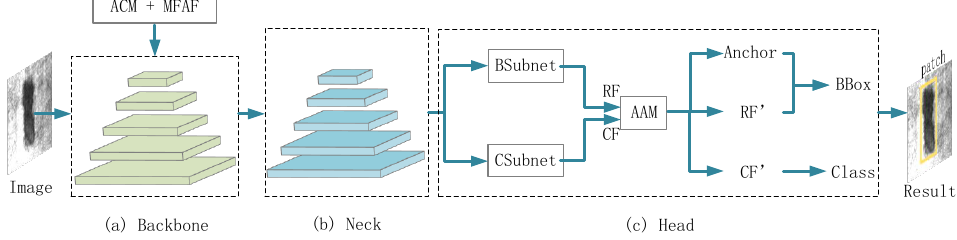
Figure 2. Architecture of the proposed